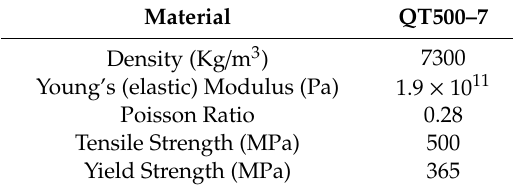
Table 1. Material characteristics of spheroidal graphite cast iron QT500-7.